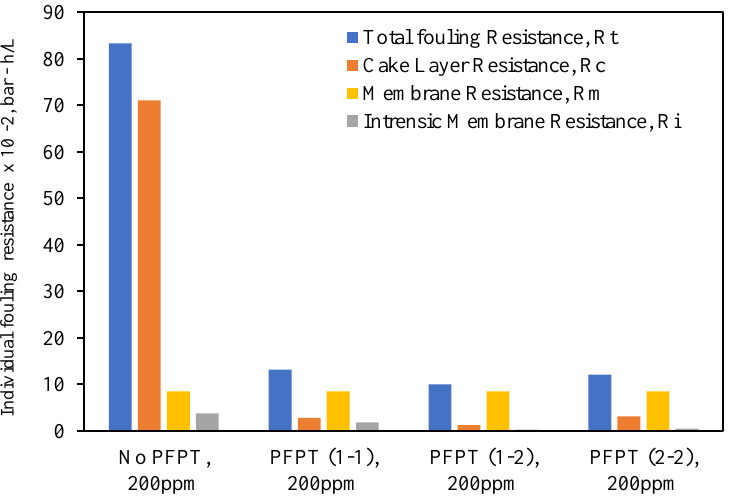
Figure 16. Individual fouling resistances for standard filtration and PFPT for a feed of 200 ppm at the TMP: 1.5 bar and CFV: 1 m/s.